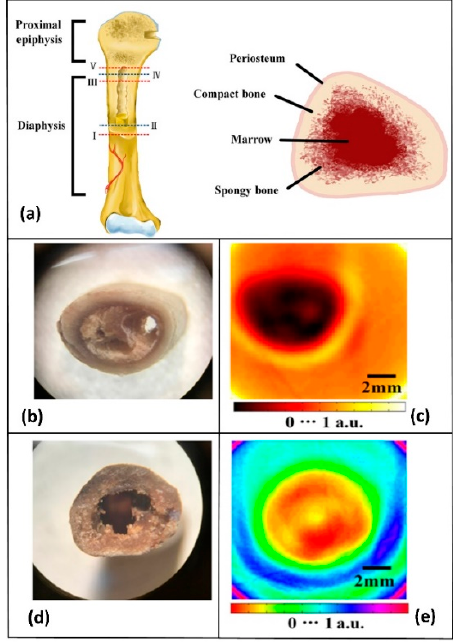
Figure 16. The reconstructed image of the chicken ulna obtained with CW THz-CT: ( a ) Schematic diagram and sketch image of 2D cross-sectional image of the chicken ulna; ( b , d ) Photos of sections II and IV of the chicken ulna; ( c , e ) The corresponding 2-D cross-sectional images [97]. Copyright © 2018, Society of Photo-Optical Instrumentation Engineers (SPIE). Table 1. Current CW THz imaging studies with biomedical samples.